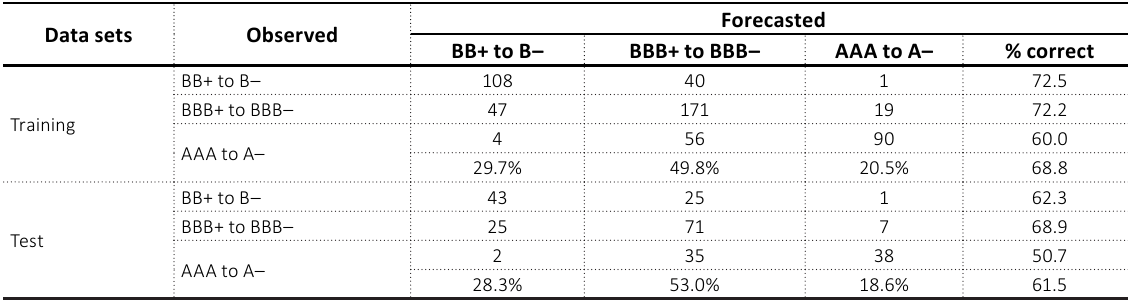
Table 11. Classification with a network in three classes (sample I, S&P).